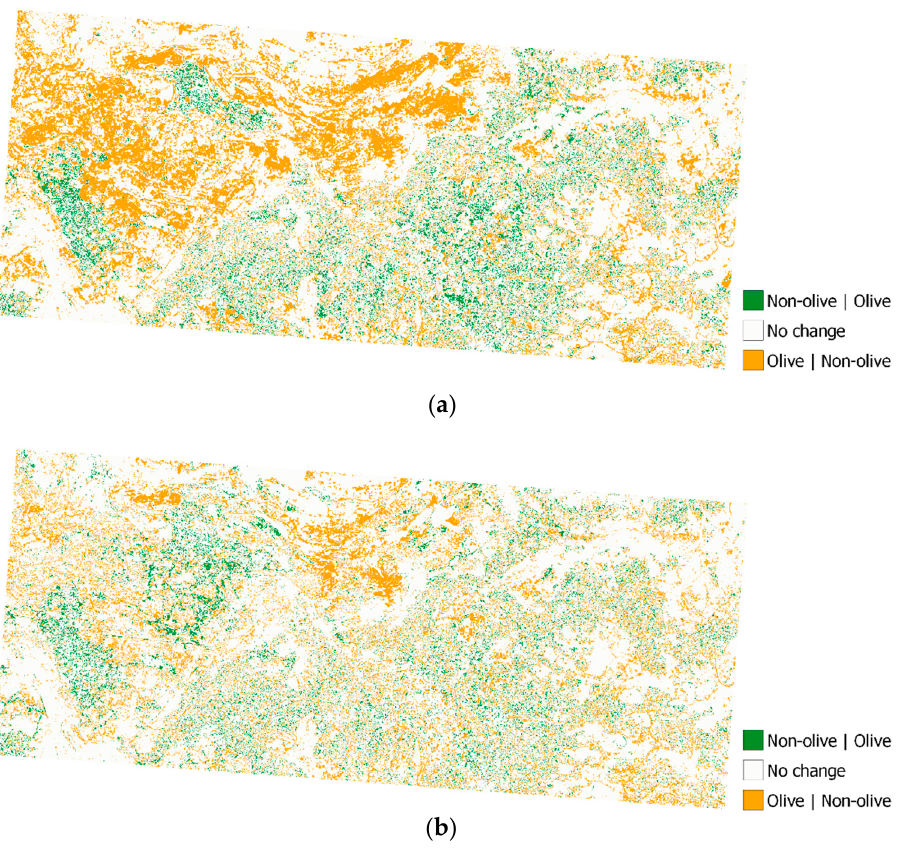
Figure 6. Raster subtraction of classification maps between: ( a ) the baseline pipeline and the multi- classifier pipeline using MLP; ( b ) the baseline pipeline and the multi-classifier pipeline using OCSVM. X|Y indicates class X in the baseline pipeline was classified as class Y in the multi-classifier pipeline.